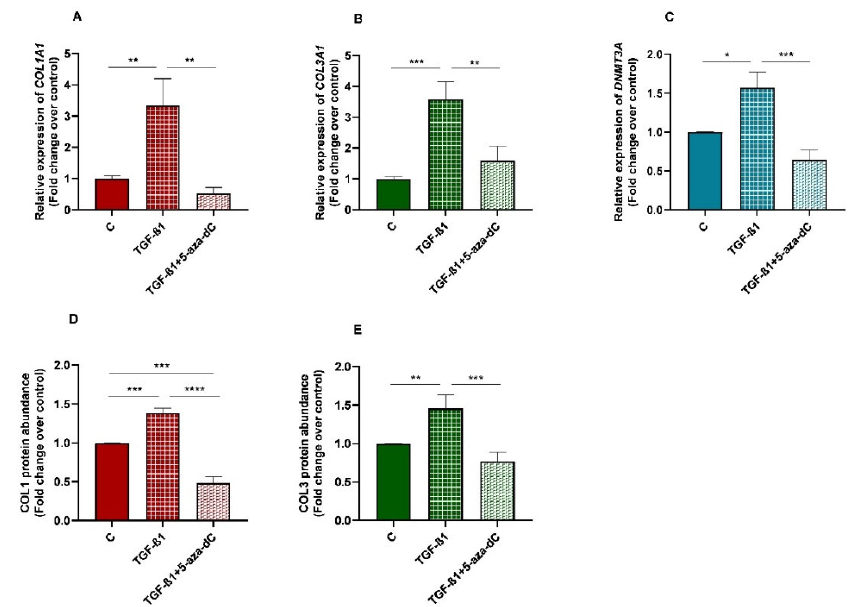
Figure 8. Relative levels of ( A ) collagen type I ( COL1A1 ), ( B ) collagen type III ( COL3A1 ), and ( C ) DNA methyltransferase 3A ( DNMT3A ) mRNA, and of ( D ) COL1 and ( E ) COL3 protein concentrations in non-treated (control-C) endometrial fibroblasts or treated with TGF- β 1 (10 ng/mL) for 96 h or TGF- β 1 (10 ng/mL) + 5-aza-dC (1 µ M) (TGF- β 1 followed by 5-aza-dC at 48 h—total cell incubation of 96 h); n = 5. Bars represent mean ± SEM. Asterisks indicate significant differences between treatments (* p < 0.05, ** p < 0.01, *** p < 0.001, **** p < 0.0001).